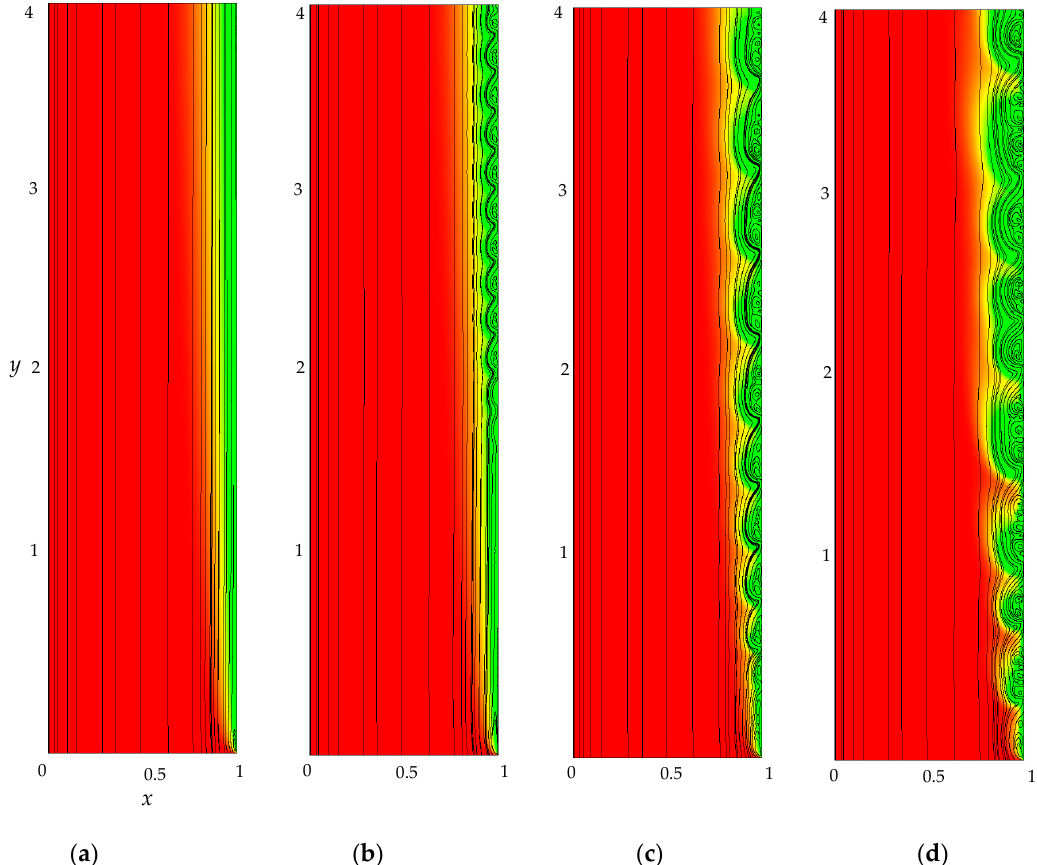
Figure 8. Distribution of cation concentration (the magnitude is shown by different color), solution streamlines (black lines) at t = 70, i av / i lim =1 ( a ), 1.2 ( b ), 1.5 ( c ), 2 ( d ).